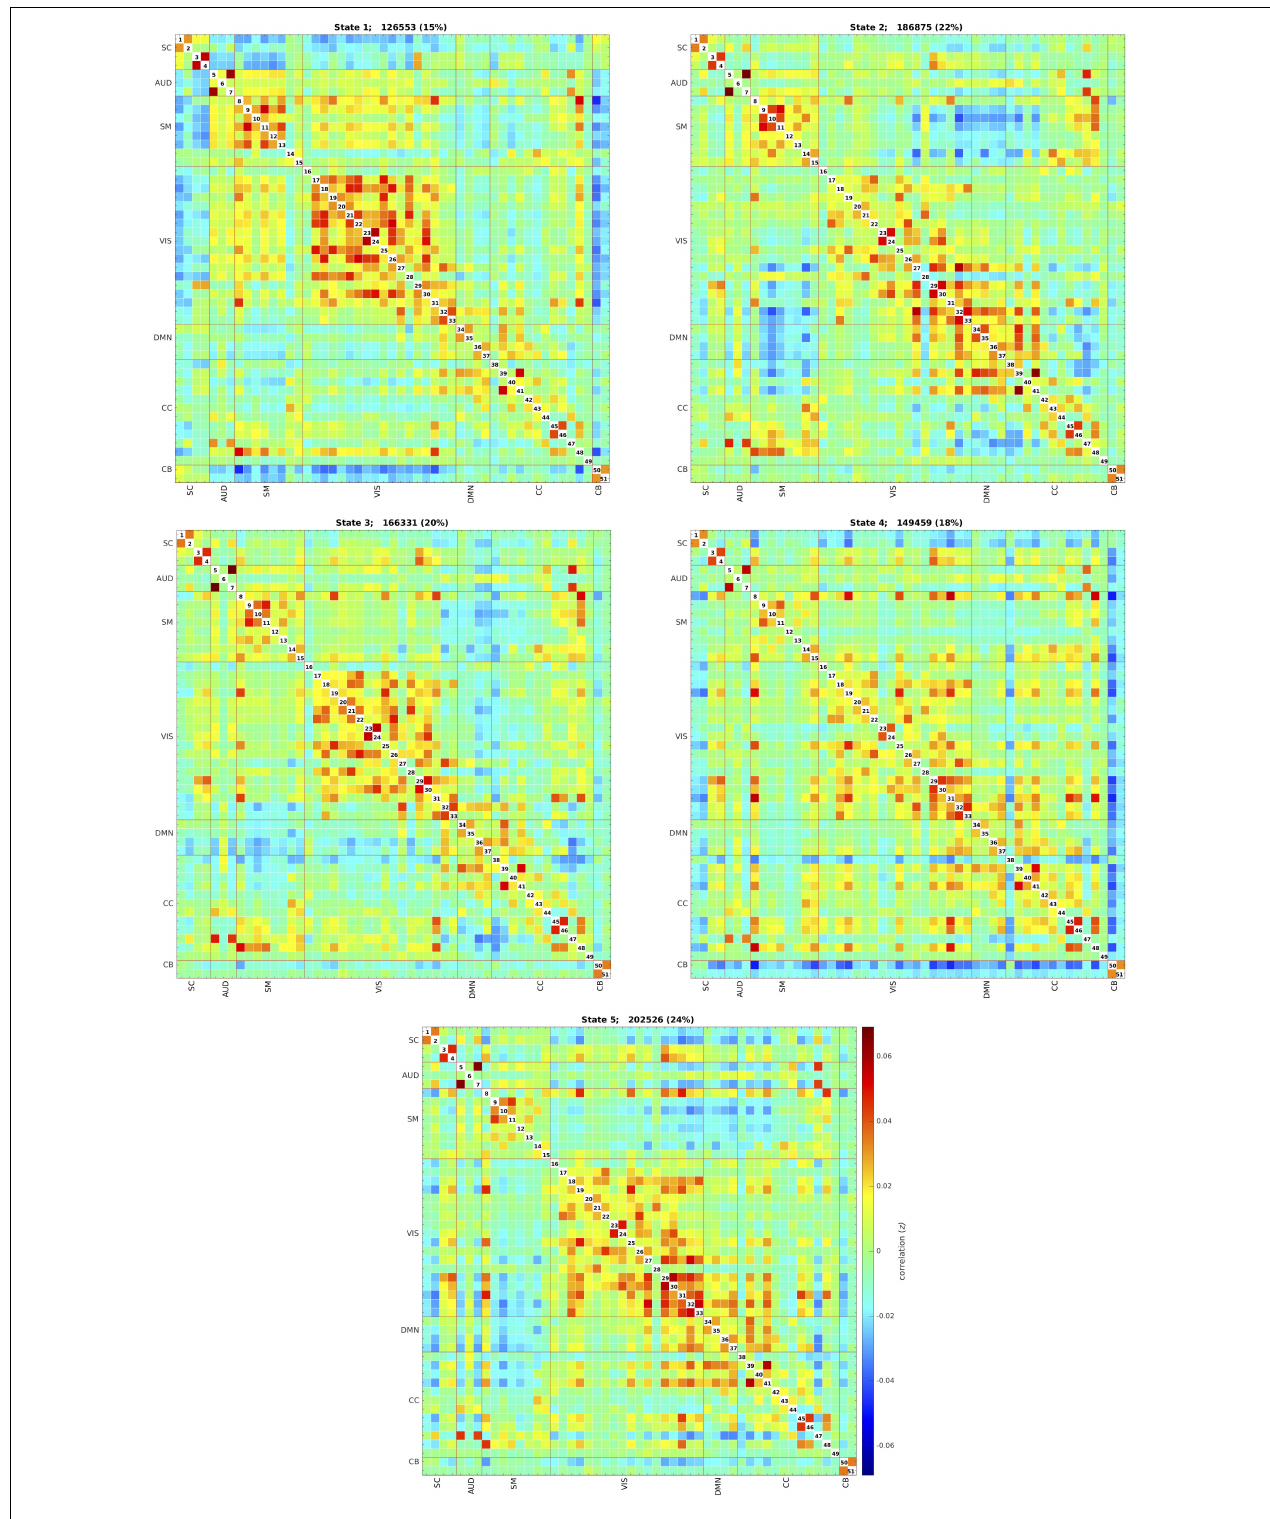
FIGURE 3 | Five dynamic states after clustering across all individuals and visits. Each state captures a particular connectivity ‘configuration’ a participant may display over the course of the MRI scan. The total number and percentage of occurrences (windows of time) is listed above each state. SC, subcortical network; AUD, auditory network; SM, sensorimotor network; VIS, visual network; DMN, default-mode network; CC, cognitive control network; CB, cerebellar network.